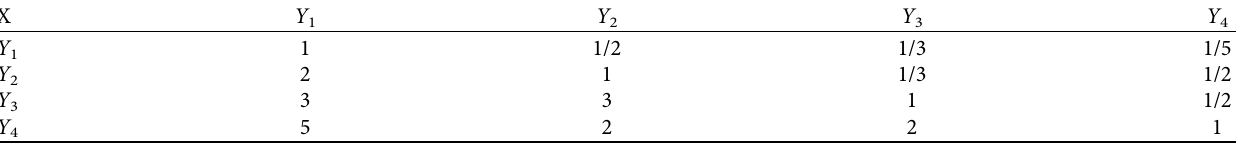
Table 5: Comparison matrix of total index in the assessment index system.